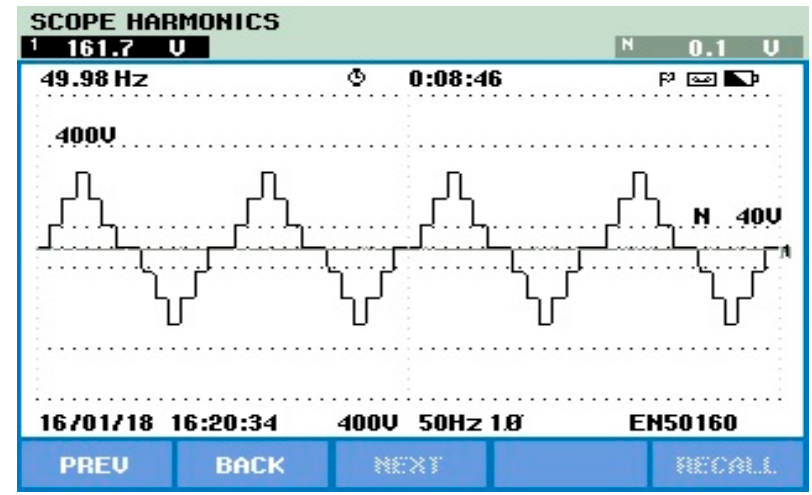
Figure 30. TLBDCLCHB inverter output using the EPCAD technique.